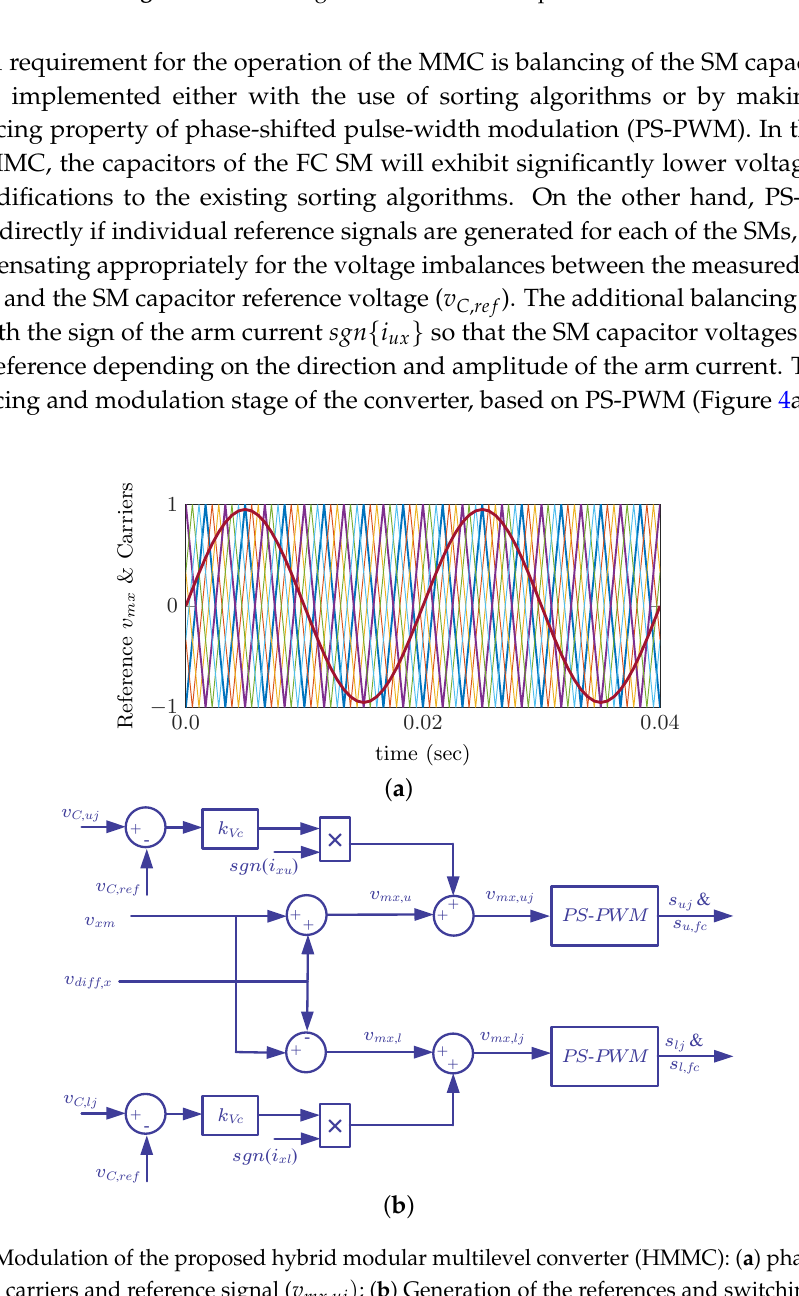
Figure 3. Circulating current controller implementation.